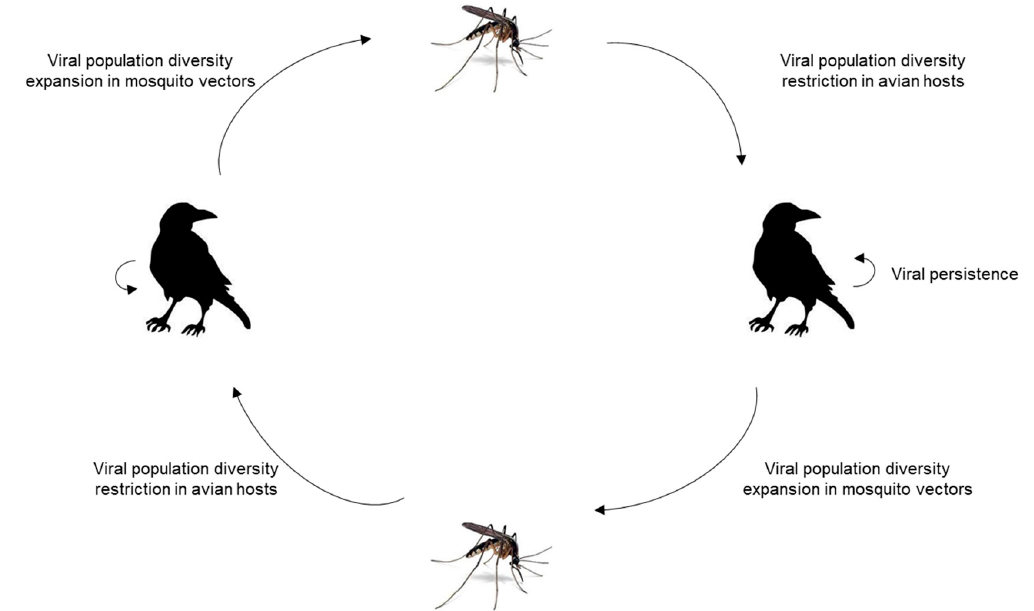
Figure 4. WNV evolution through genetic diversity balance between the avian hosts and mosquito vectors. Viral diversity increases in mosquitoes and decreases in birds.